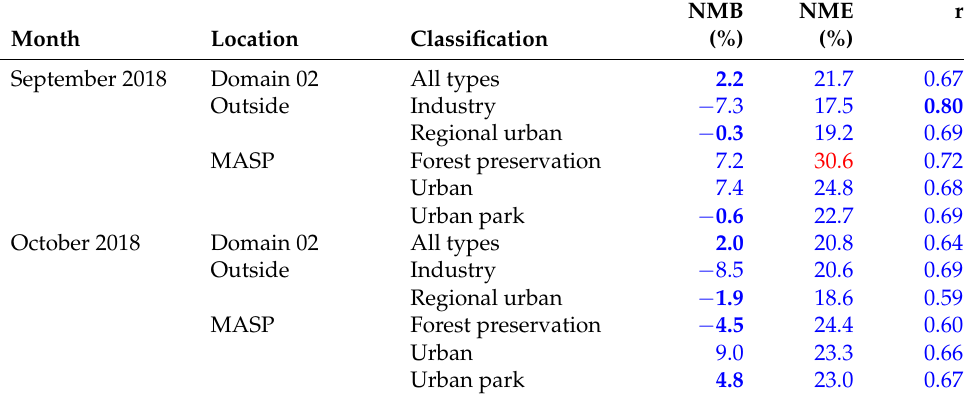
Table 2. Surface ozone model performance evaluation: statistical results